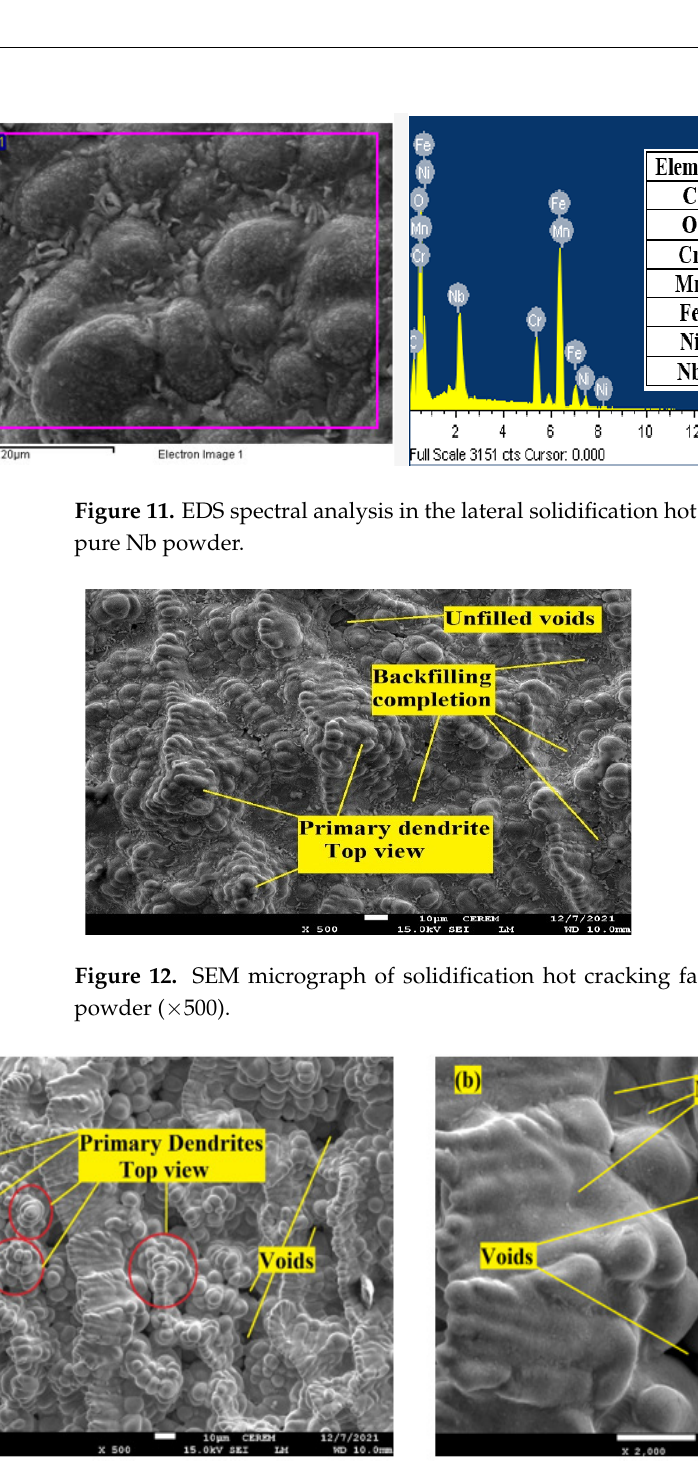
Figure 13. Micrograph of crack face of TIG weld specimen coated with the mixture of powders (80% Nb + 20% Ti) ( a ) (×500) and ( b ) (×2000).